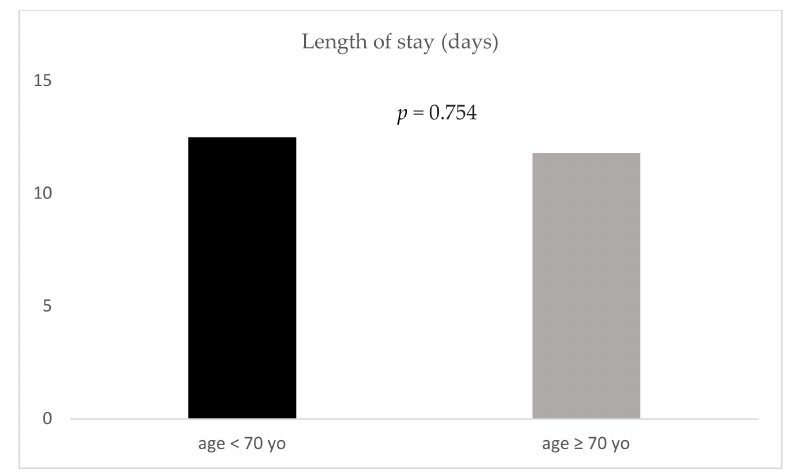
Figure 2. Length of stay for the two age groups; yo: years old.